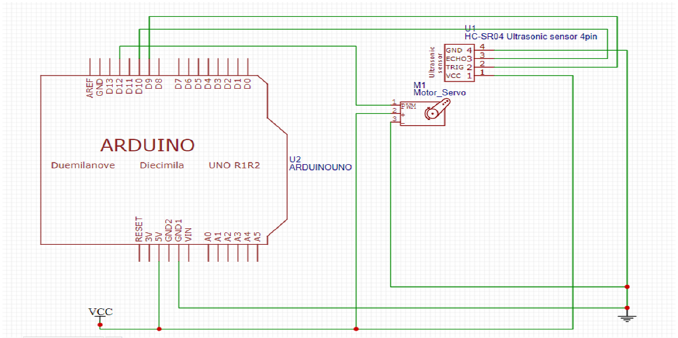
Fig. 2 Construction of circuit diagram in the simulation stage to test the experiment result before the